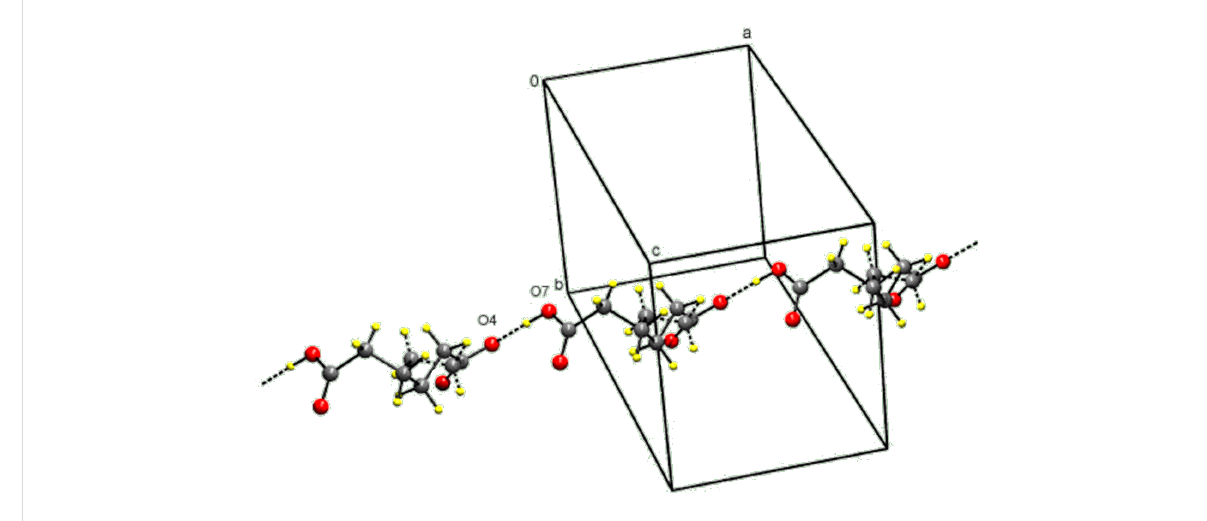
Figure 7: The supramolecular chain made up of hydrogen adipate in the compound 2 .